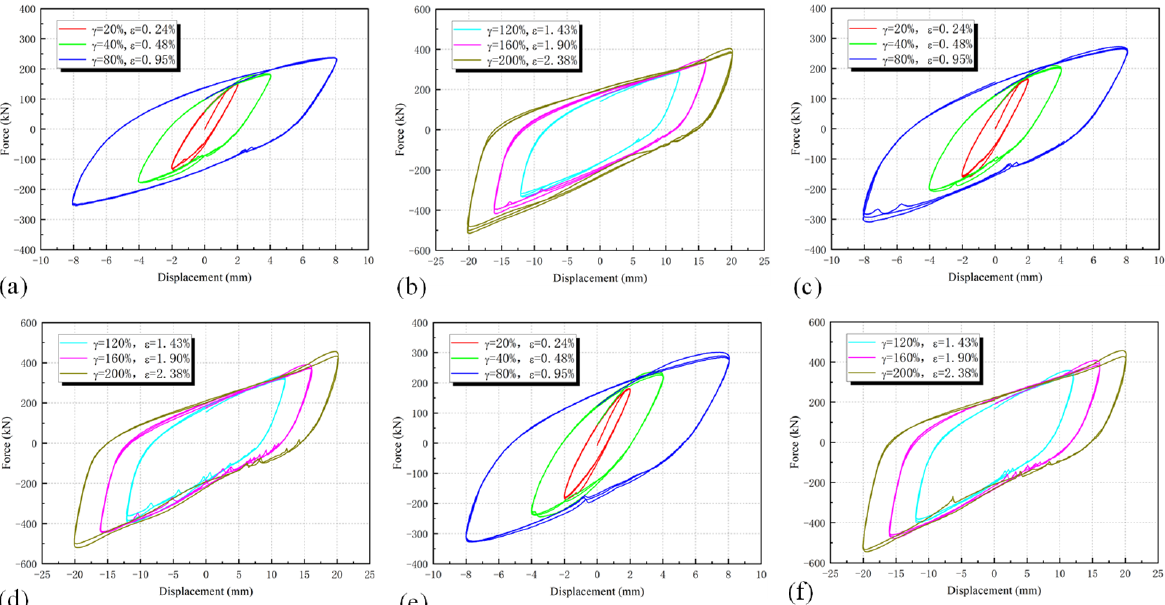
Figure 4. Hysteresis curves of VBRB (displacement dependency): ( a ) VBRB1, 0.2 Hz, γ = (20~80%); ( b ) VBRB1, 0.2 Hz, γ = (120~200%); ( c ) VBRB2, 0.3 Hz, γ = (20~80%); ( d ) VBRB2, 0.3 Hz, γ = (120~200%); ( e ) VBRB3, 0.6 Hz, γ = (20~80%); and ( f ) VBRB3, 0.6 Hz, γ = (120~200%).